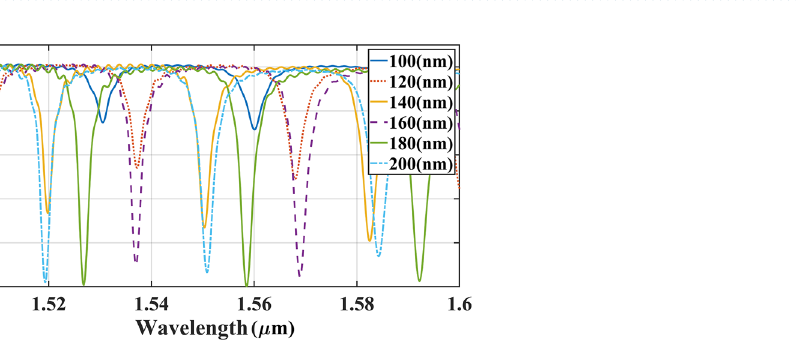
Figure 7. The transmission spectrum of ICCRR versus the asymmetry parameter (AP) for the applied parameters of Lc = 0 µm, gap = 180 nm , WSi_out = 190 nm and WSi_sum = 300 nm .